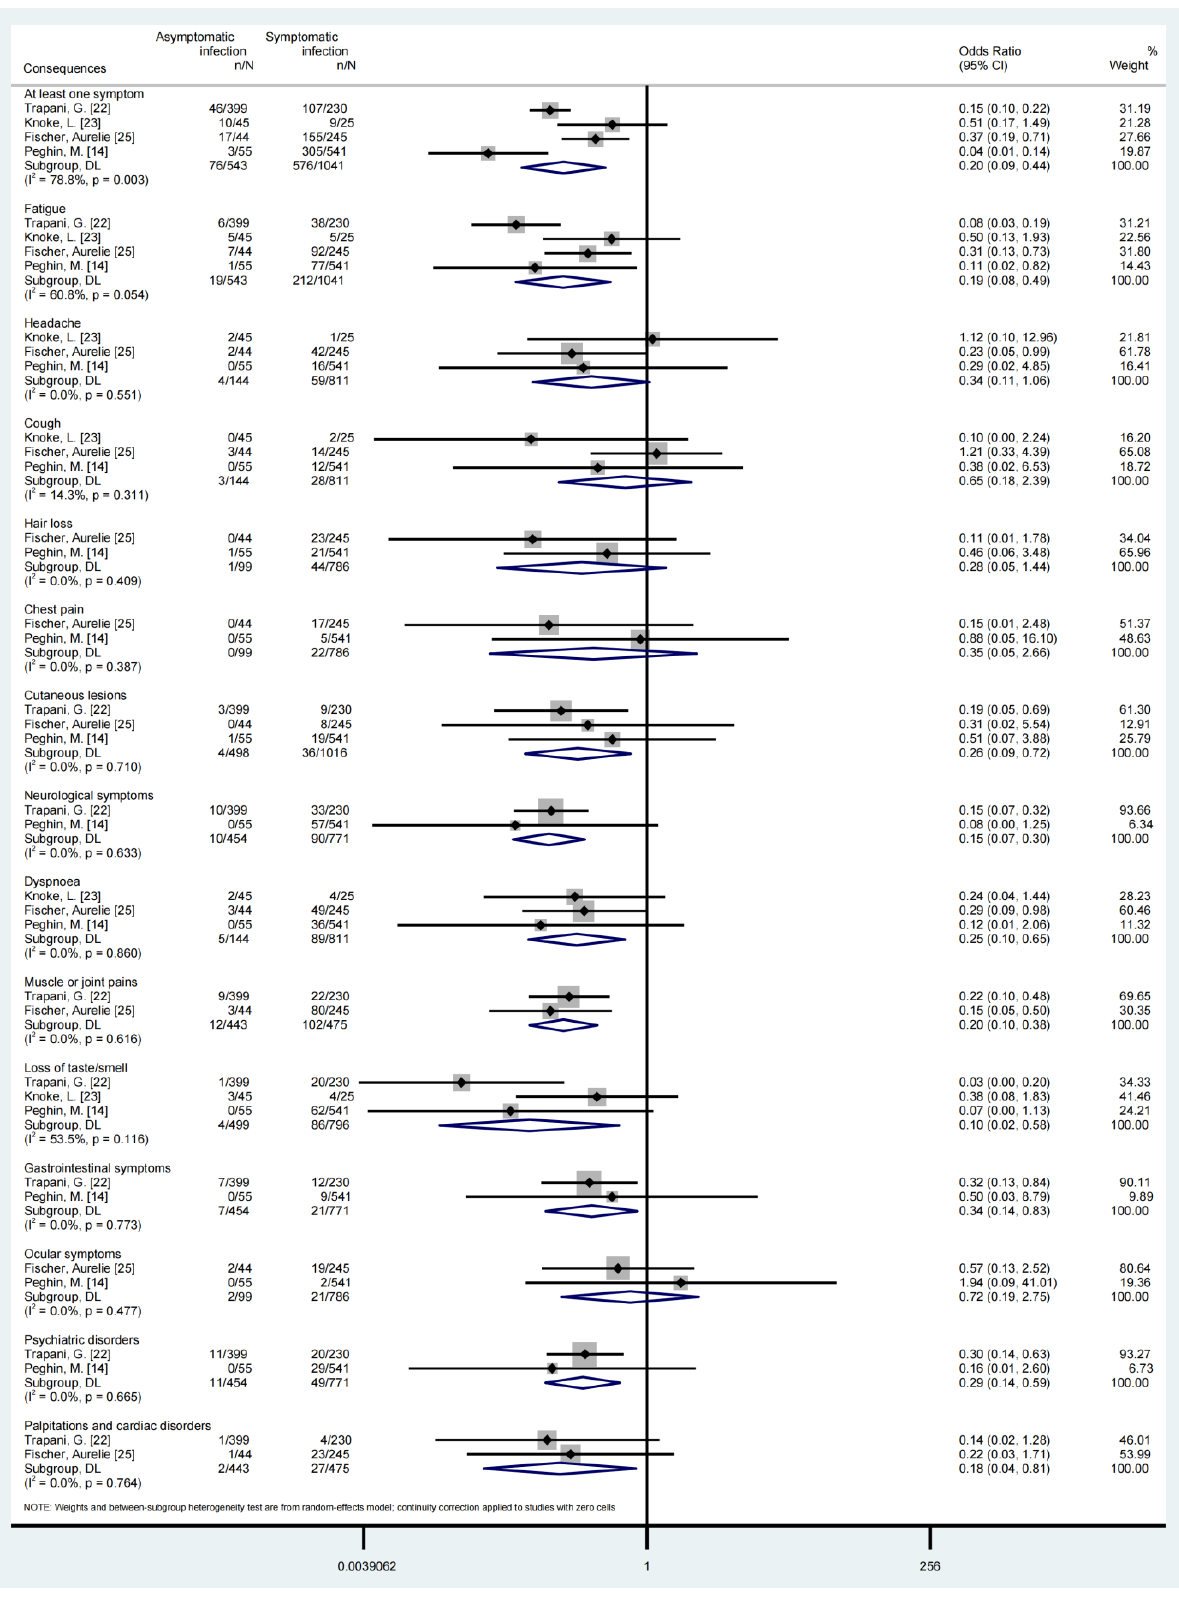
Figure 3. Forest plot of long-term consequences of asymptomatic or symptomatic SARS-CoV-2 in- fection [14,22,23,25].